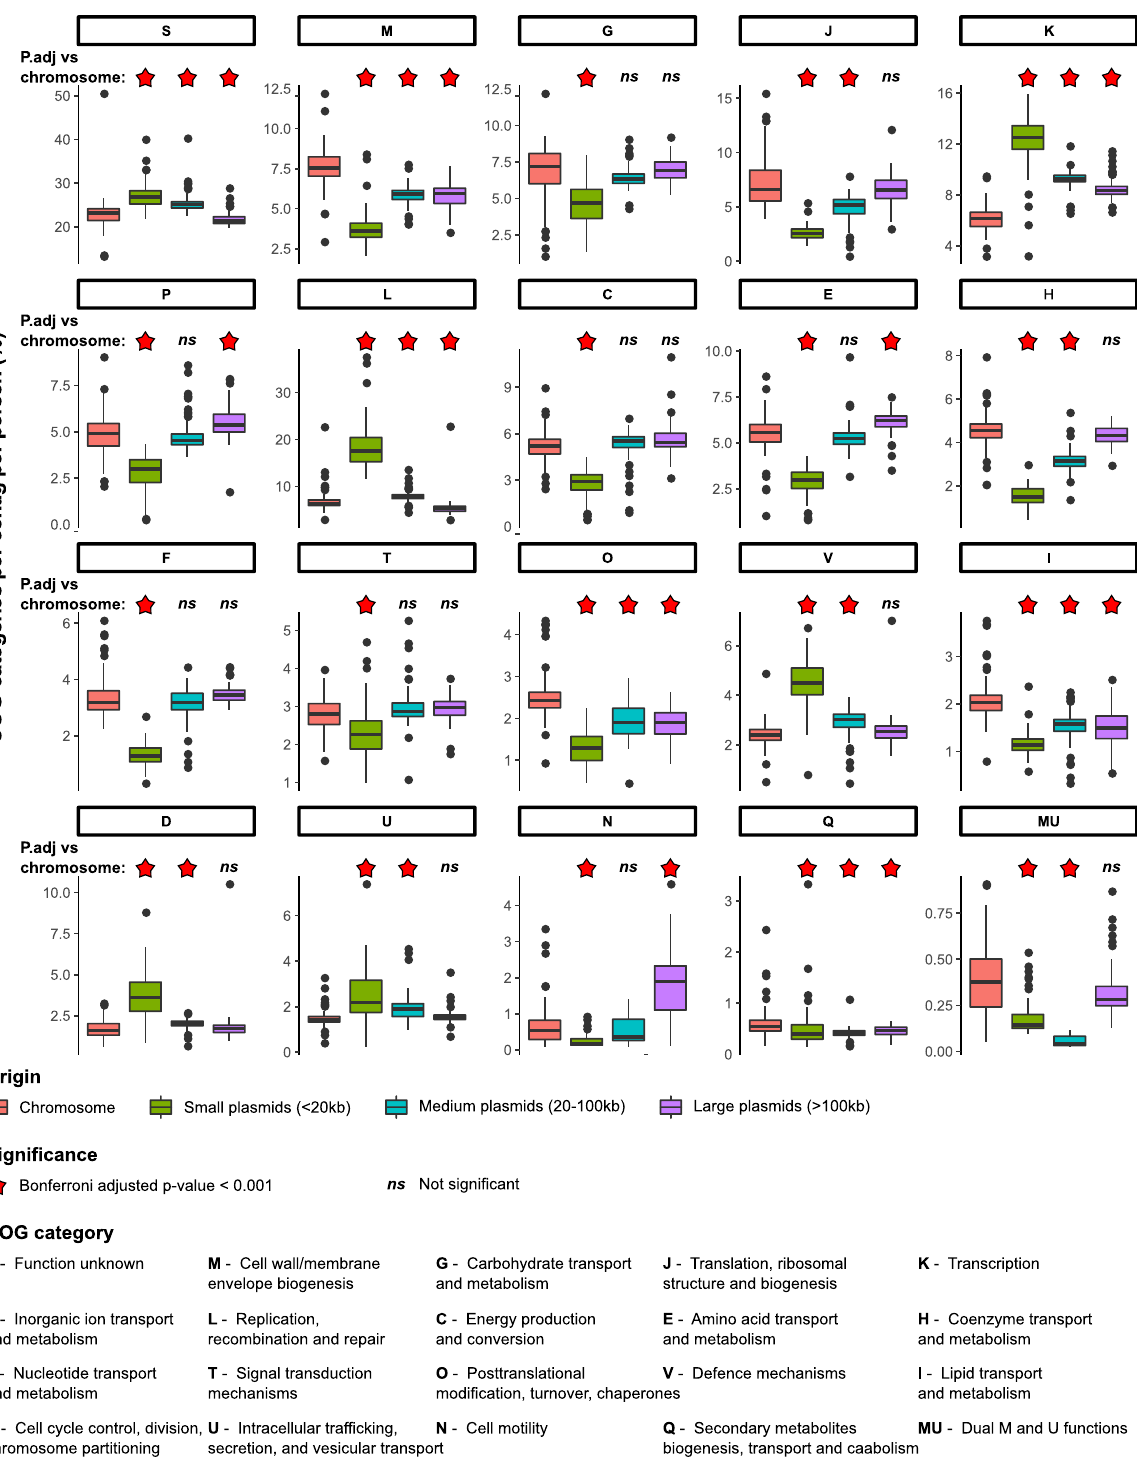
Figure 3. Human microbiome plasmids fulfil ecologically distinct roles. Comparison of the percentage of COG categories per contig encoded on bacterial chromosomes (≥ 100 kb) versus small (≤ 20 kb), medium (20–100 kb), and large (≥ 100 kb) plasmids within human